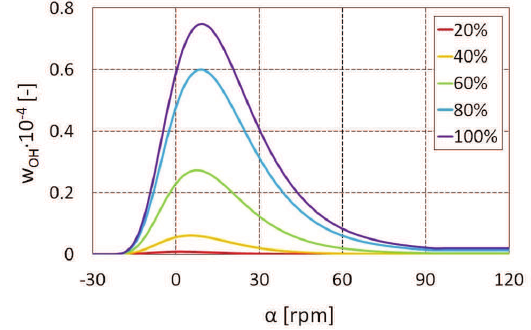
Fig. 8. Mass fraction of hydroxyl radicals – W OH for various engine load (engine speed 1800 rpm, methane content in fuel 40% (w/w))